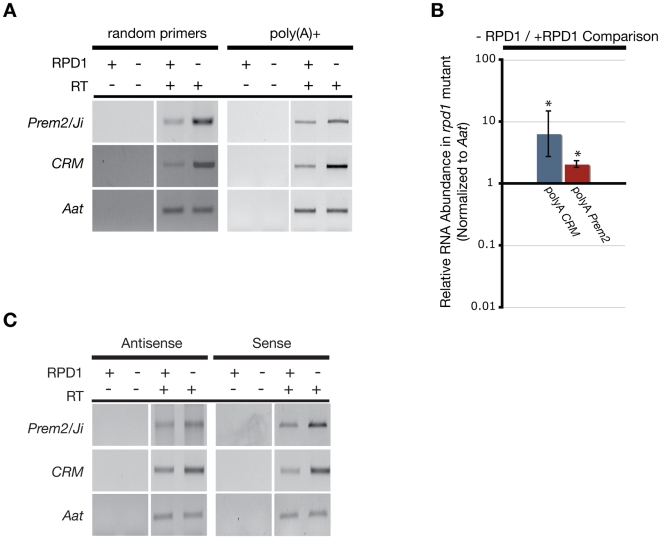
Loss of RPD1 function results in an increase in LTR RNA transcript levels.(A) Representative RT–PCR products amplified from random-primed cDNA from total and poly(A)-enriched RNA in rpd1 (rmr6-1) mutants (−) and non-mutants (+). (B) qRT–PCR comparison of change in the relative abundance of polyadenylated CRM and Prem2/Ji in rpd1 mutants relative to non-mutants (+/− 2 s.e.m.). “*” values are significantly different by a two-sample z-test (p<0.05). (C) Strand-specific RT–PCR products from rpd1 mutants (−) and non-mutants (+).